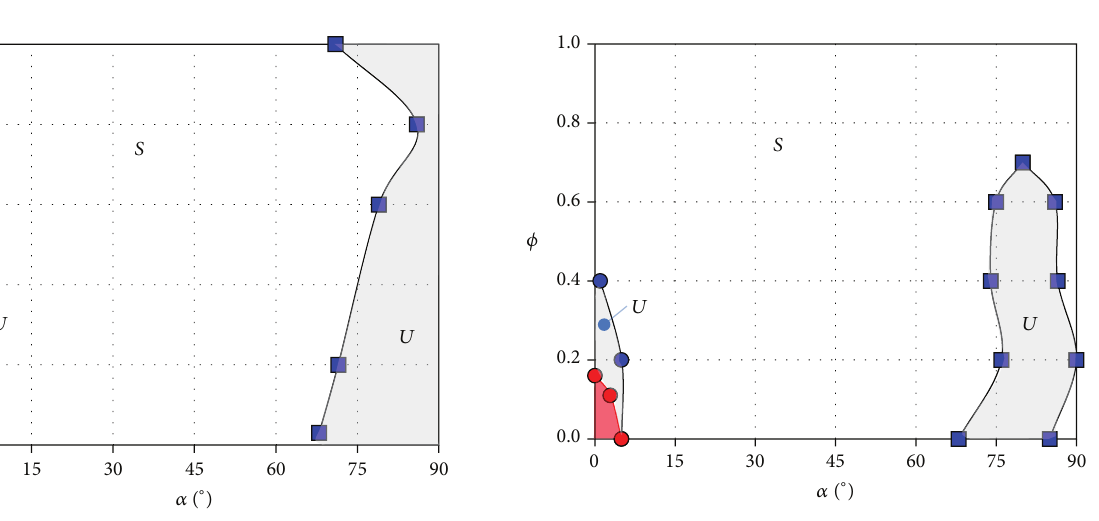
Figure 6: Stability diagram of H-section beams in the H geometry versus angle of attack plane ( 2𝑎/𝑐 versus 𝛼 plane), where the lengths 𝑎 and 𝑐 are defined in Figure 2. Shadowed areas indicate unstable regions, although the right hand side region is only marginally unstable according to Gand´ıa et al. [16].